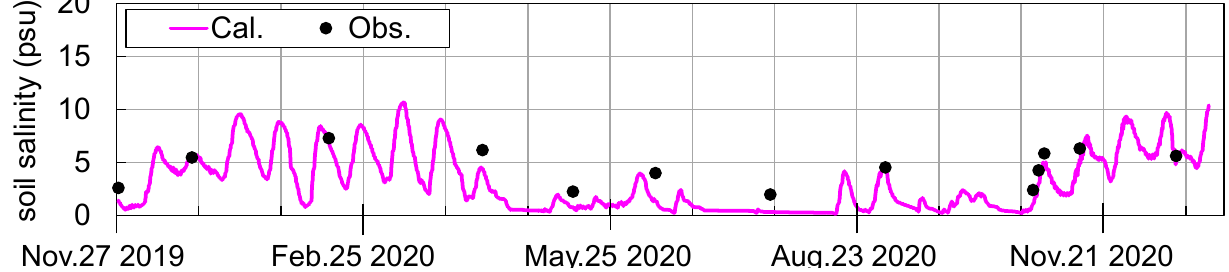
Figure 11. Verification result of soil salinity at marsh.